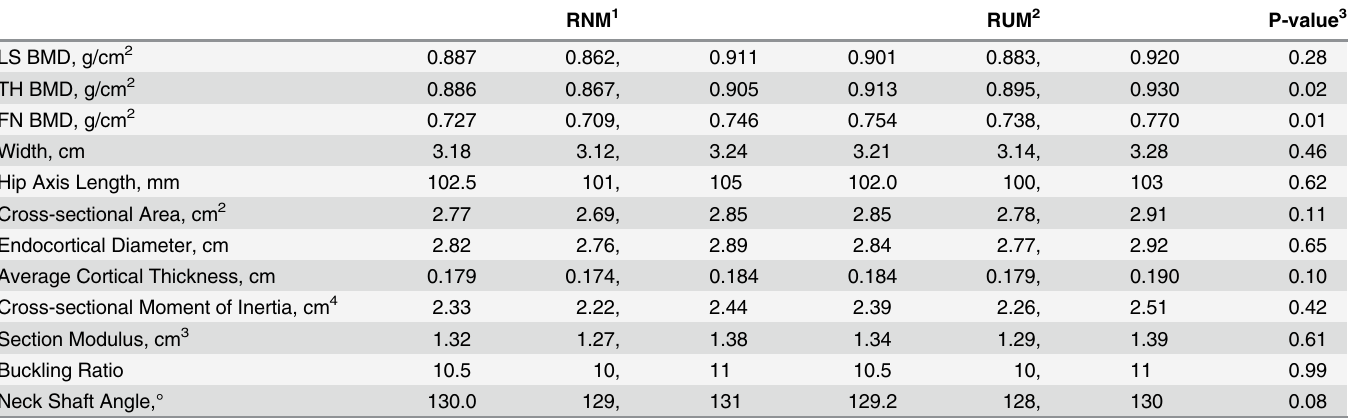
Table 2. Bone characteristics with mean and 95% CI for groups and comparisons between RNM and